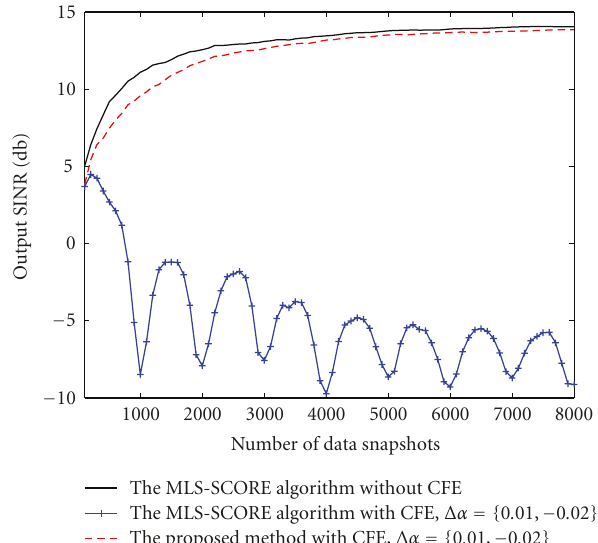
Figure 1: Output SINR versus number of data snapshots for Example 1 .